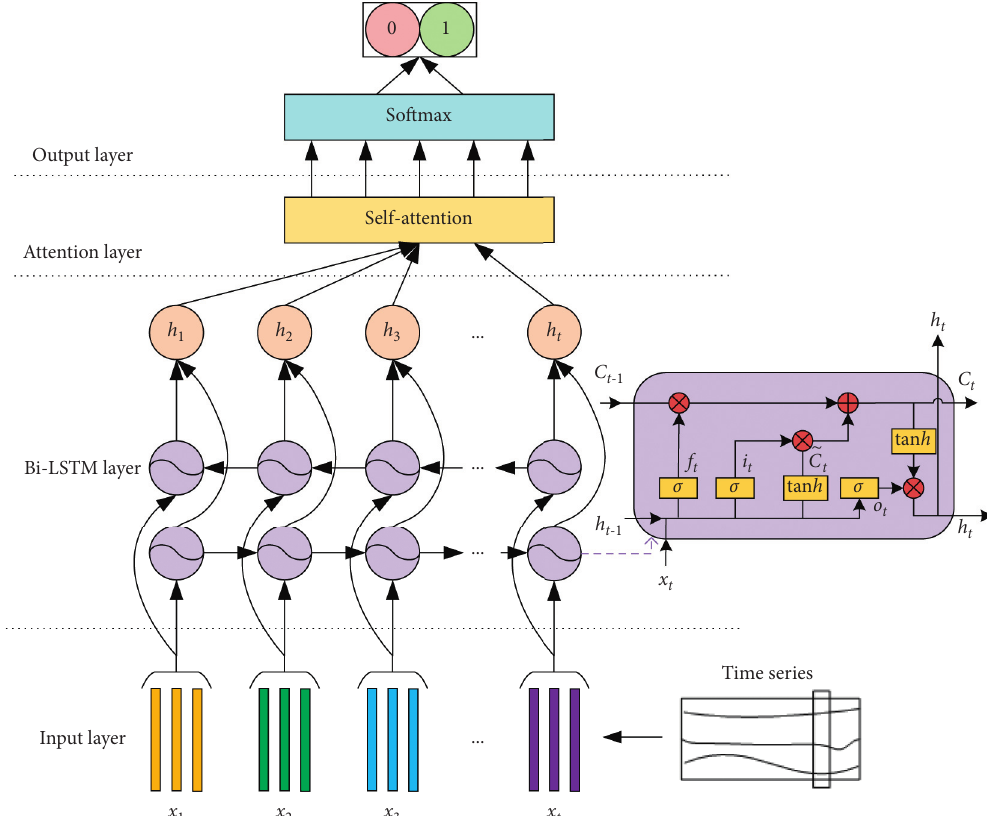
Figure 5: Bi-LSTM framework with the attention